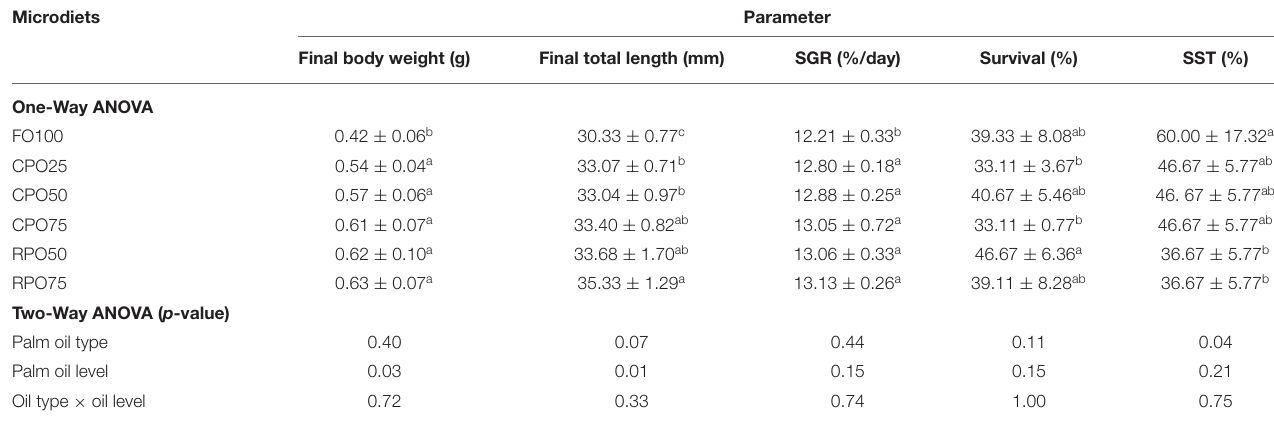
TABLE 2 | Growth and survival performance of Asian seabass Lates calcarifer fed different microdiets for 33 days.